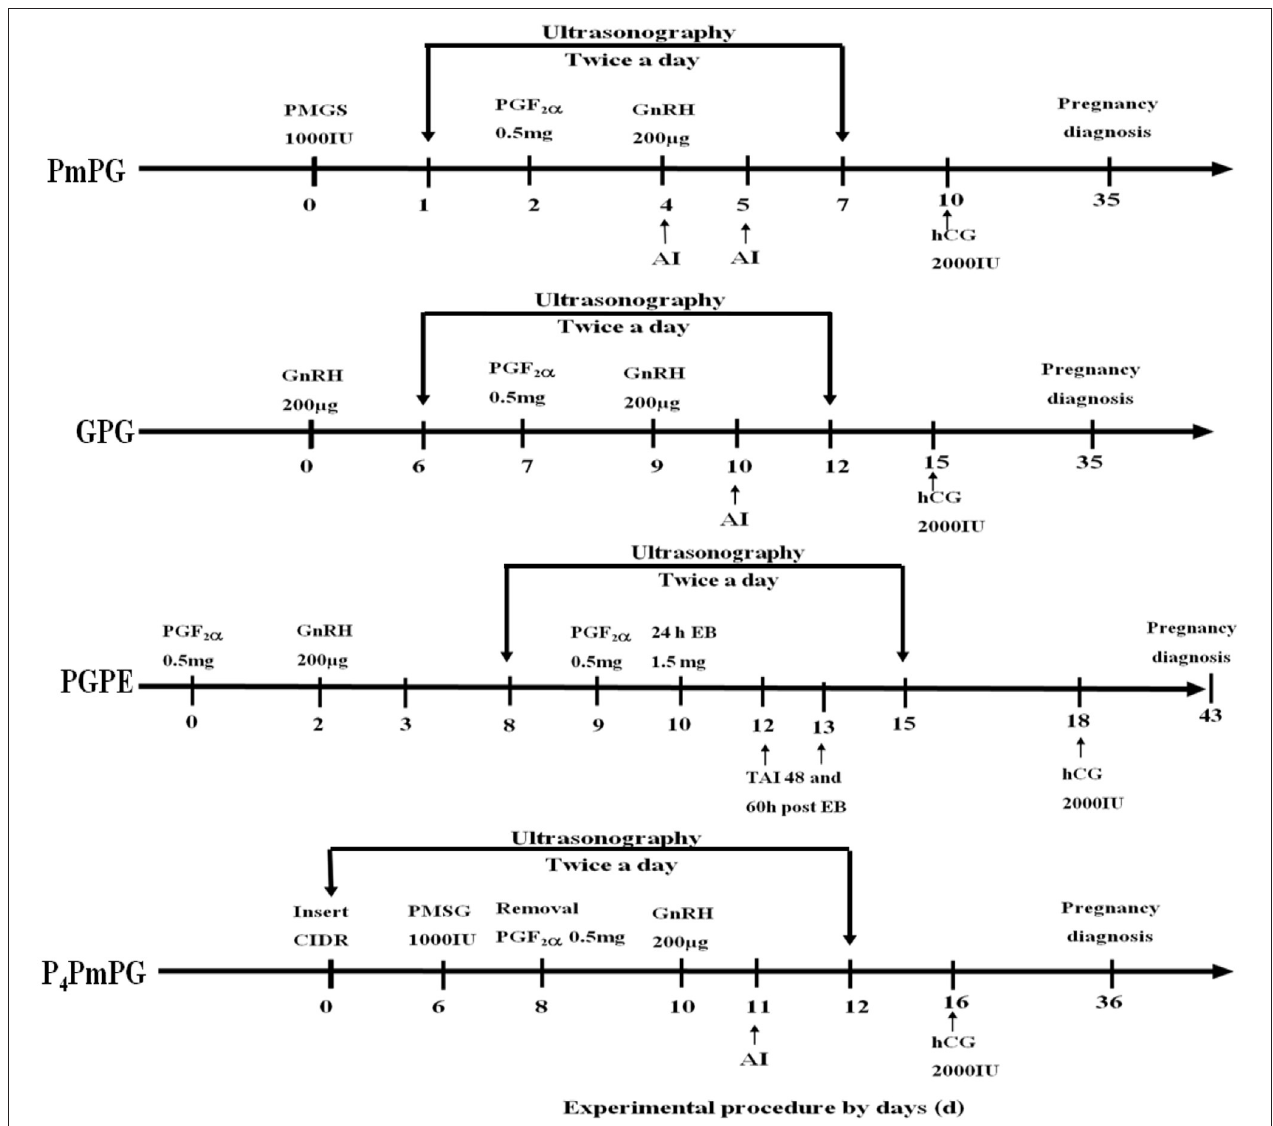
FIGURE 1 | Schematic diagram of four conventional synchronization-TAI protocols (P 4 PmPG, GPG, PGPE, and PmPG) used in crossbred buffaloes during breeding season. The two downward vertical arrows in the window present the ultrasonographic observations of buffaloes synchronized through P 4 PmPG, GPG, PGPE, and PmPG